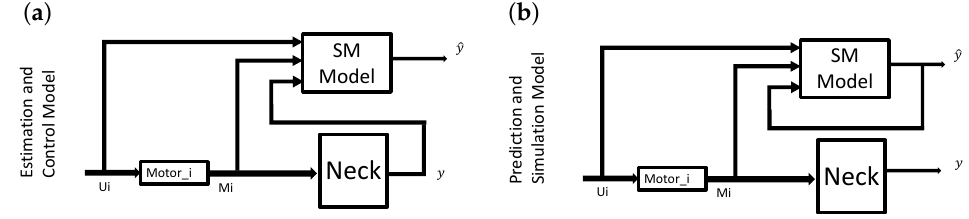
Figure 3. Model architectures. ( a ) An estimation and control model. ( b ) A prediction and simulation